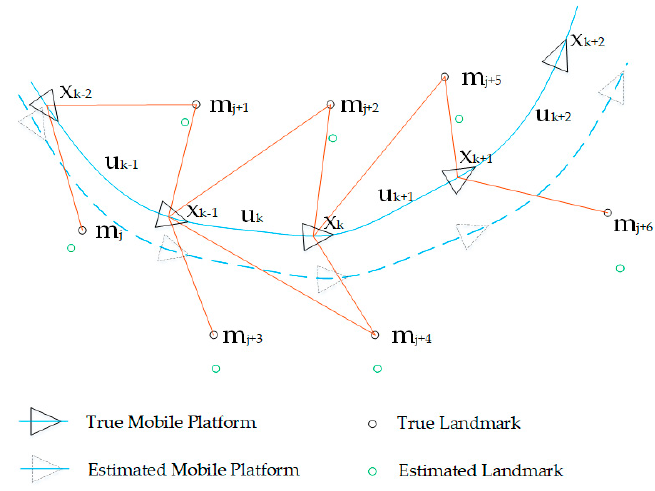
Figure 1. The simultaneous localization and mapping (SLAM) problem. Here, x k is the state vector describing the pose of the mobile platform at time k ; u k is the motion vector describing the movement of the platform from time k − 1 to time k ; m j is the vector describing the position of the jth landmark.